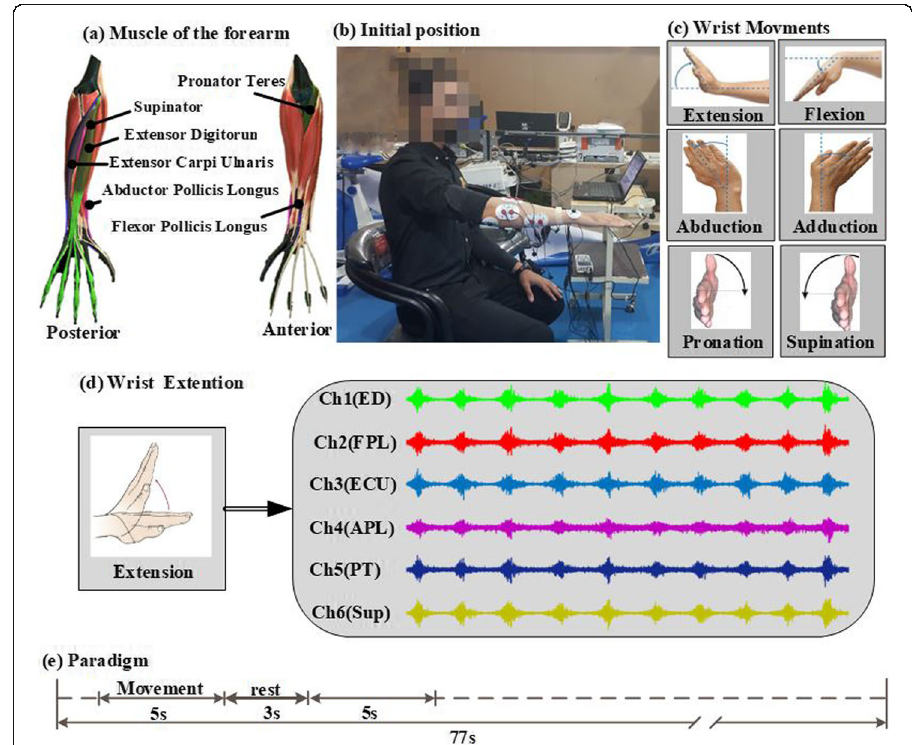
Fig. 1 Experiment setup. a Surface electrode placement on forearm muscles. b Initial wrist position. c Wrist movements. d The muscles activity of wrist extension consist of extensor digitorum (ED), flexor pollicis longus (FPL), extensor carpi ulnaris (ECU), abductor pollicis longus (APL), pronator teres (PT), and supinator (Sup) for 10 times repetition. e Test paradigm which the recording protocols were carried out according to